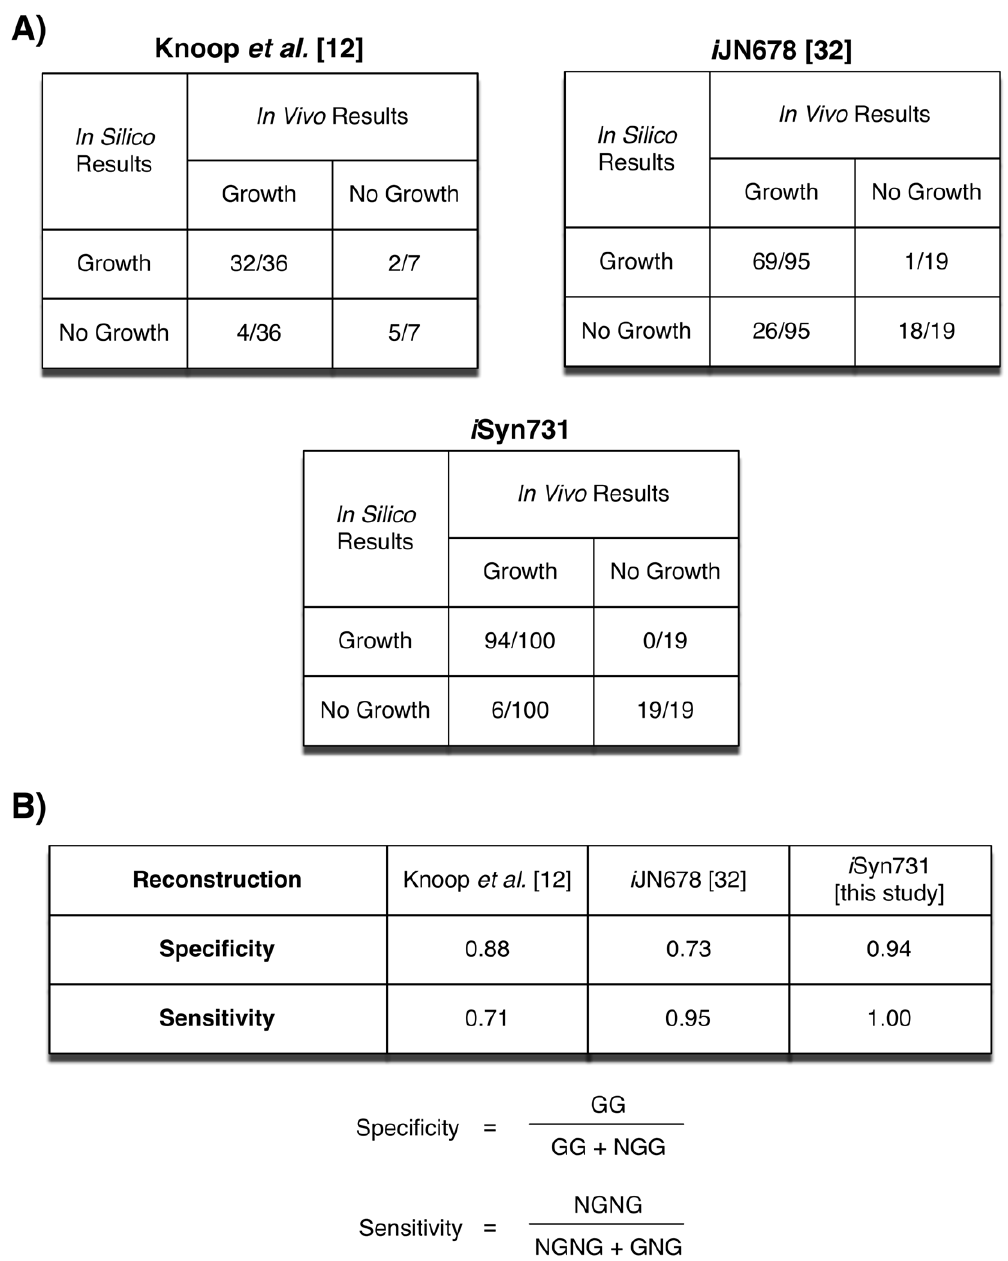
Figure 2. Comparison of gene essentiality/viability data with predictions by a number of Synechocystis 6803 models. (A) Tabulated growth (i.e., G) or non-growth (i.e., NG) predictions and experimental data. The first number denotes the number of GG, GNG, NGG and NGNG combinations whereas the second number signifies the number of experimentally observed lethal (or viable) mutants, and (B) Definition and comparison of specificity and sensitivity of all three models. Note that GG denotes both in silico and in vivo growth, NGG represents no growth in silico but in vivo growth. NGNG implies no growth for either in silico or in vivo , whereas GNG marks growth in silico but no growth in vivo .